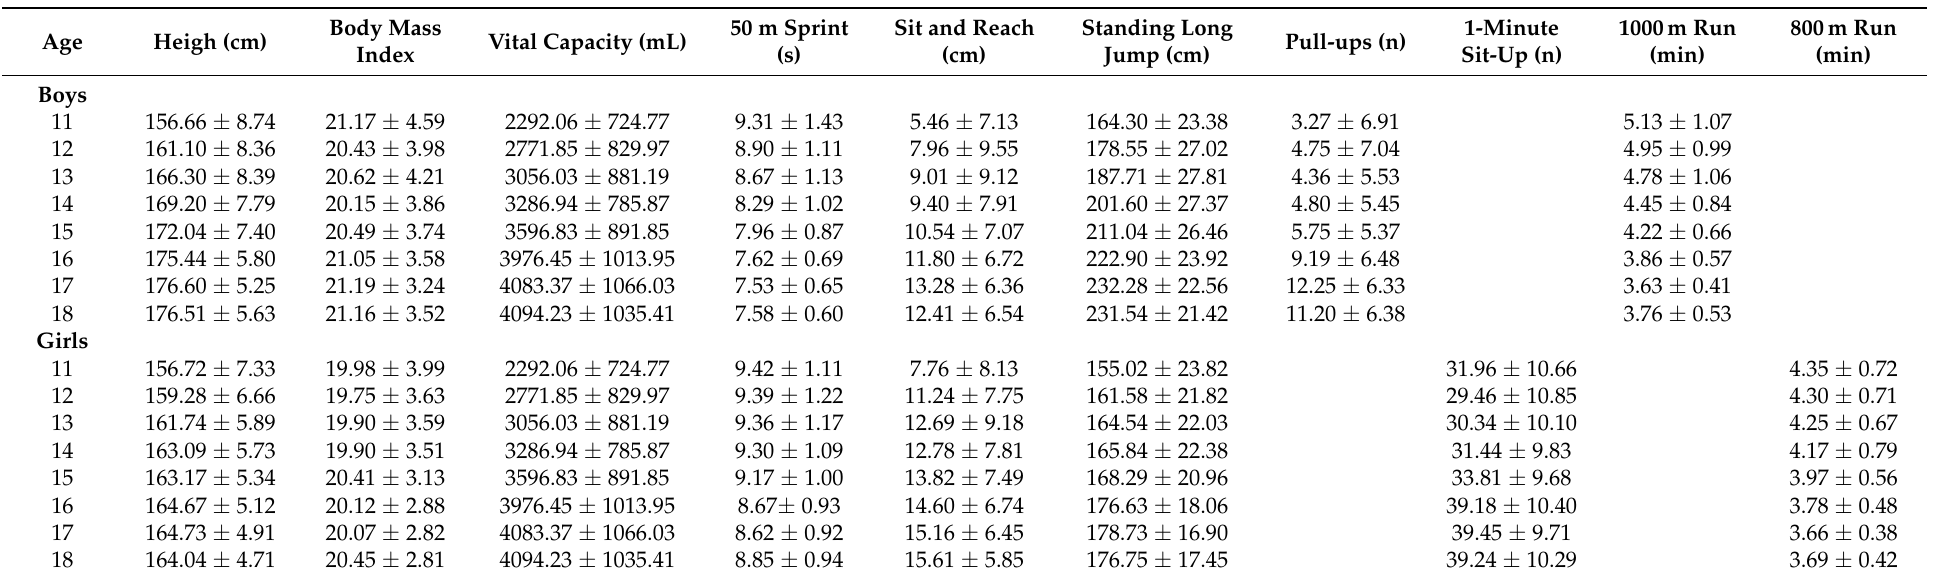
Table 3. The means and standard deviations of physical fitness tests by age and